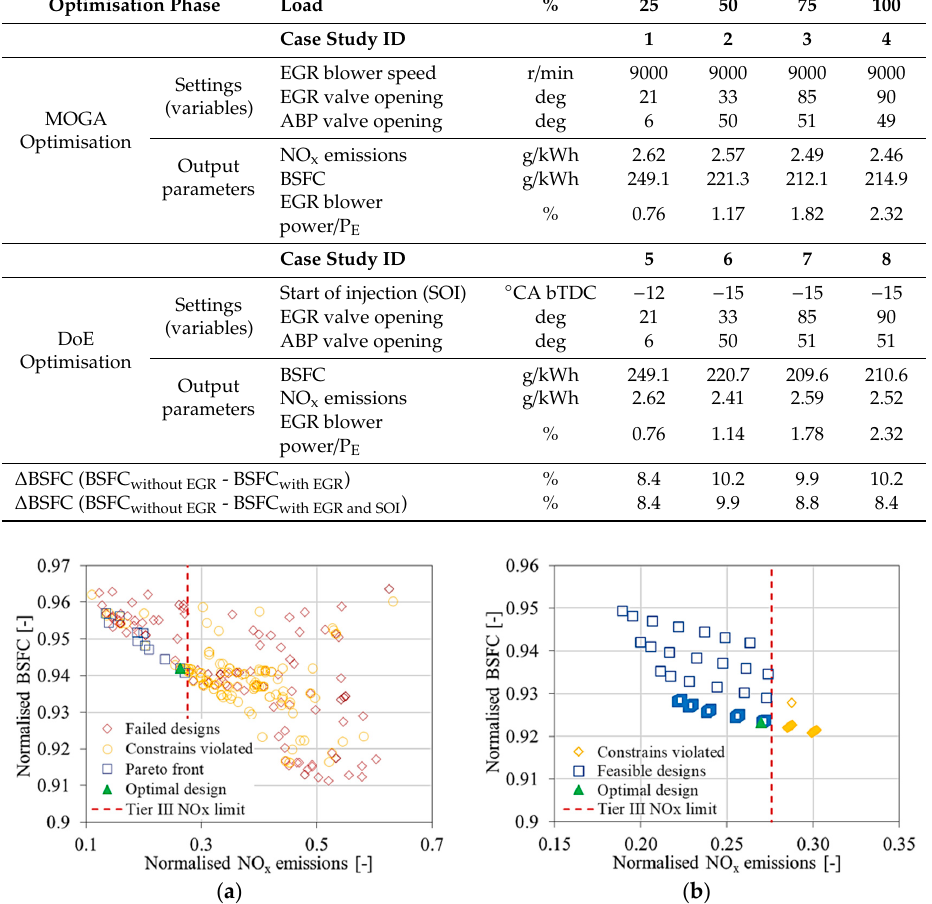
Figure 3. Optimisation results of the engine parameters in the gas mode operation at 100% load ( a ) multiobjective genetic algorithm (MOGA) (case study 4) and ( b ) design of experiments (DoE) (case study 8).